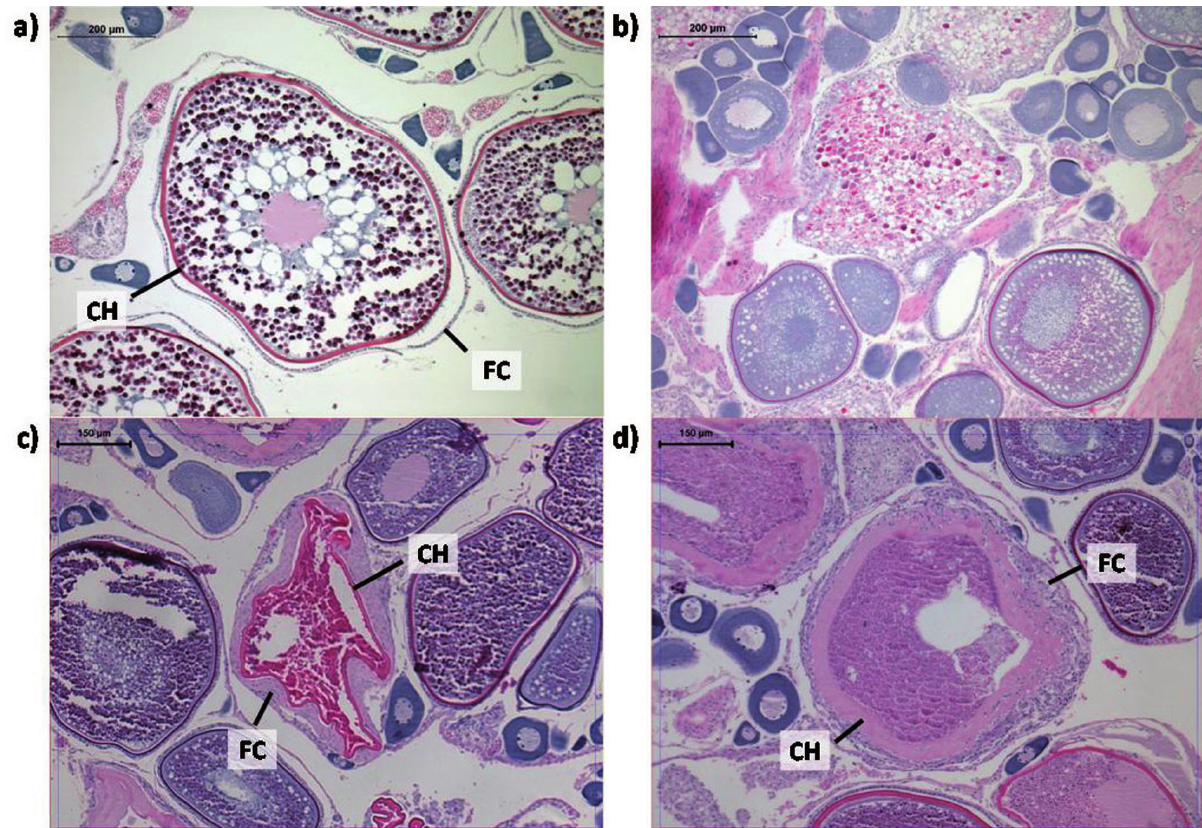
Fig. 1 . – Histological images of European hake a) normal vitellogenic follicle (scale bar=200 μm); b) normal atretic oocyte (Scale bar=200 μm); c) cystic follicles with proliferation of follicular cell layers (scale bar=150 μm) and d) cystic follicle with proliferation of follicular cell layers and a swollen chorion. FC, Follicular cells; CH, chrorion. Scale bar=150